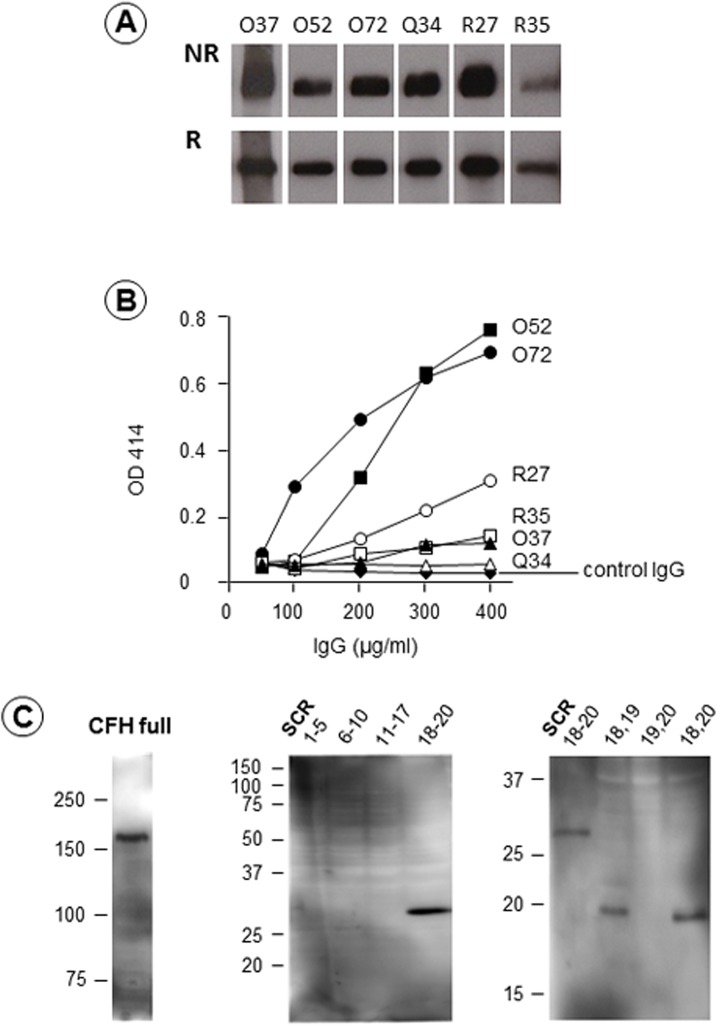
Production of six anti-complement factor H (CFH) murine monoclonal antibodies (mAbs), and their effects on lysis of sheep red blood cells (RBCs).
(A) Western blot analysis. All six anti-CFH mAbs reacted with purified human CFH on Western blot under both non-reducing (NR) and reducing (R) conditions. (B) Effects of six anti-CFH mAbs on lysis of sheep RBCs. Twenty microliters of normal plasmas spiked with anti-CFH mAbs were incubated with sheep RBCs at a final concentration of 50 μg/ml to 400 μg/ml. Two plasma samples, treated with anti-CFH mAb O52 and O72, induced strong hemolysis in a dose-dependent manner. Three mAbs (R27, R35, and O37) resulted in slightly enhanced hemolysis. As for mAb Q34, appreciable hemolysis was not detected, similar to control IgG. (C) Epitope analysis of mAb O72 using recombinant CFH expressed by yeast. The mAb O72 reacted with full length CFH (left) and short consensus repeat (SCR) 18–20 (middle). Moreover, the right panel shows that mAb O72 reacted with peptide of SCR18−19, and SCR18 and 20, but not SCR19−20, indicating that the epitope of mAb O72 resided in SCR18.